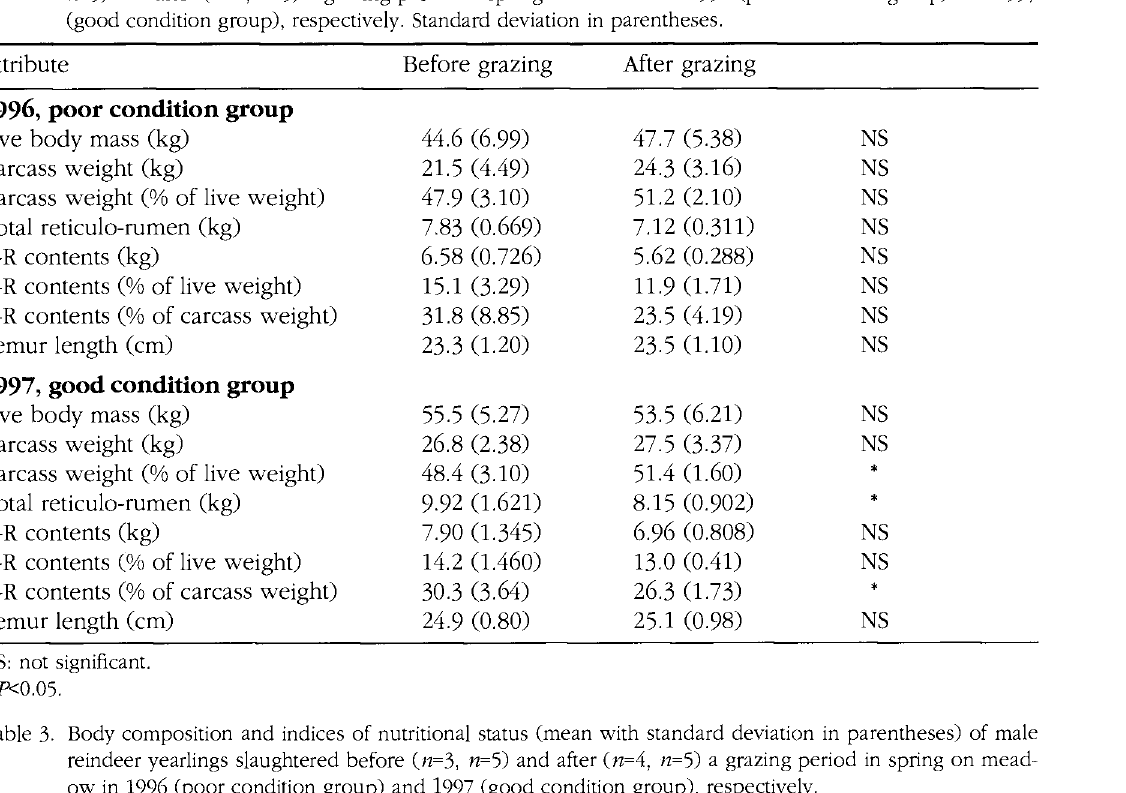
Table 2. Carcass weight, weight of reticulo-rumen (R-R) and femur length of male reindeer yearlings before (n=3, n=5) and after (n=4, «=5) a grazing I period in spring on meadow in 1996 (poor condition group) and 1997 (good condition group), respectively. Standard deviation in parentheses.